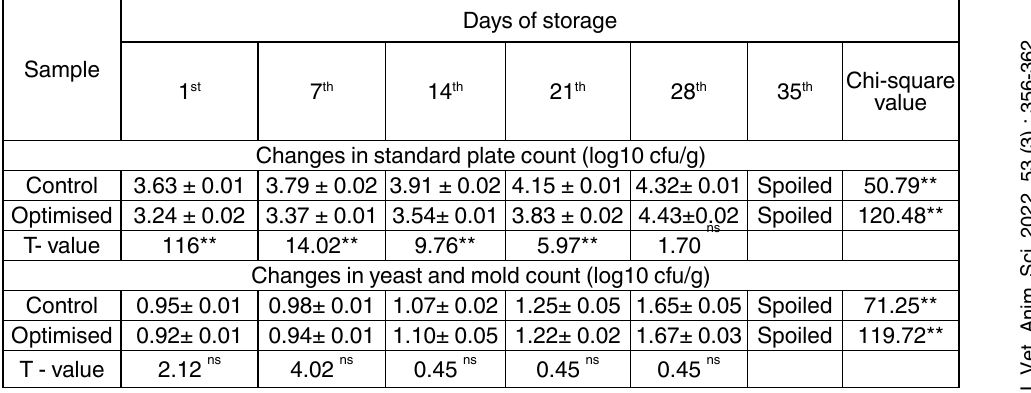
table 2 . Effect of refrigerated storage on microbiological attributes of lutein incorporated calcium and vitamin D fortified 3